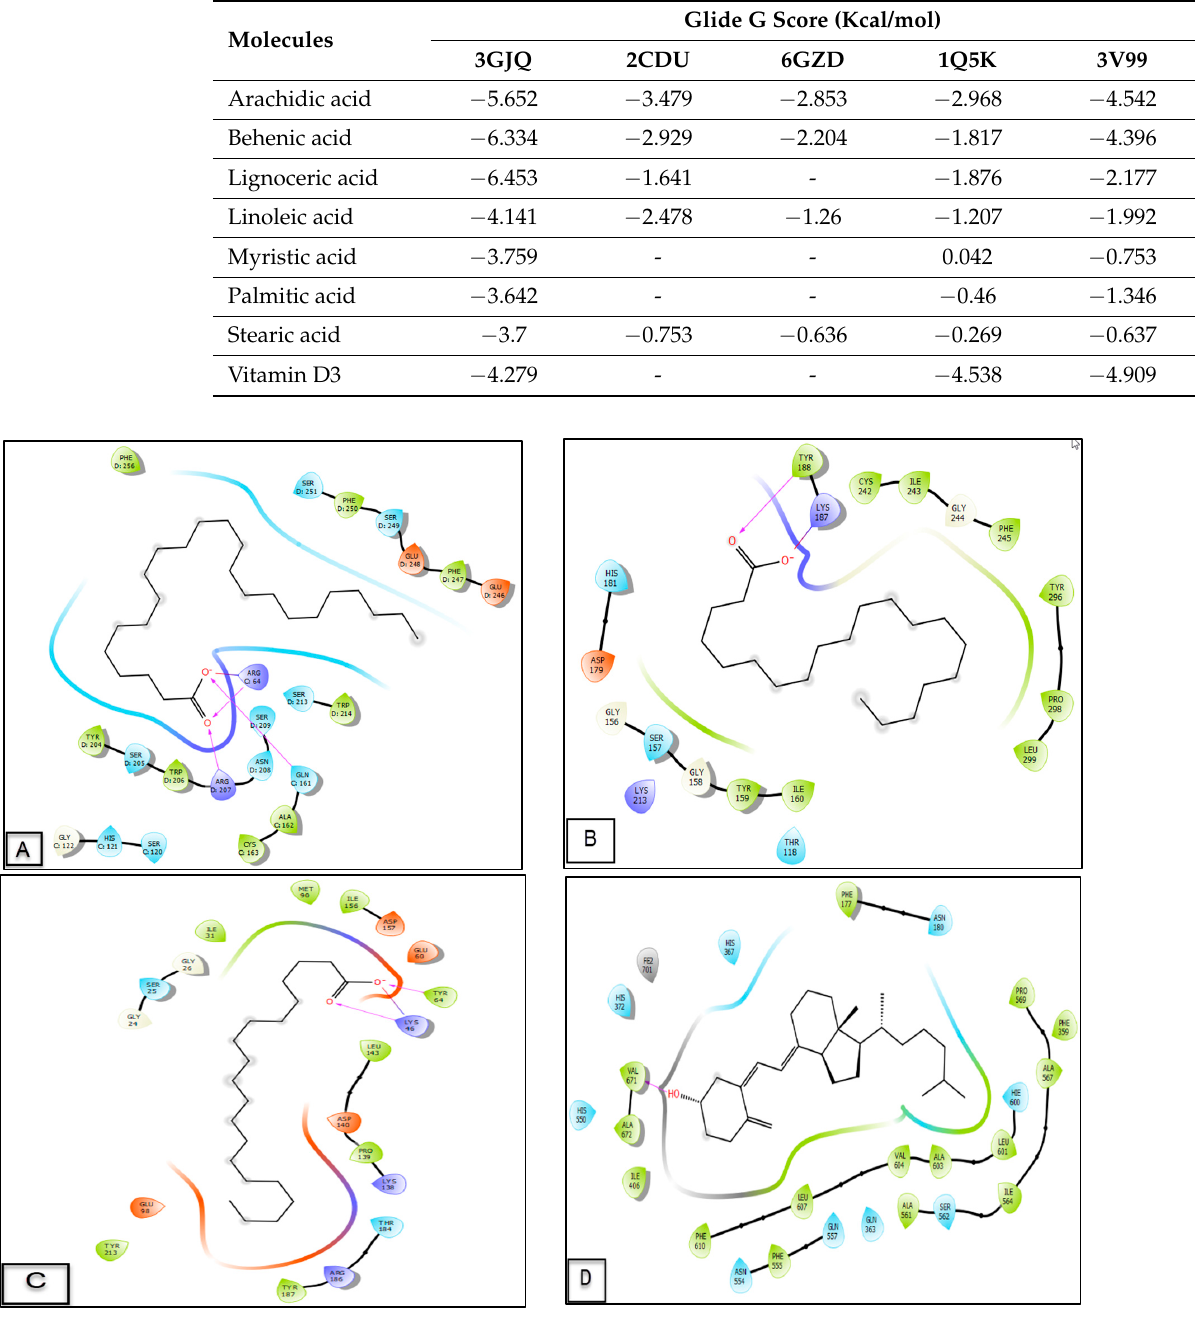
Figure 9. Two-dimensional representations of ligands interactions with the active sites. ( A ): Interactions of lignoceric acid with the caspase-3 active sites; ( B ): Interactions of arachidic acid with the NADPH oxidase active sites; ( C ): Interactions of arachidic acid with the casein kinase-1 active sites; and ( D ): Interactions of vitamin D3 with the lipoxygenase active sites.